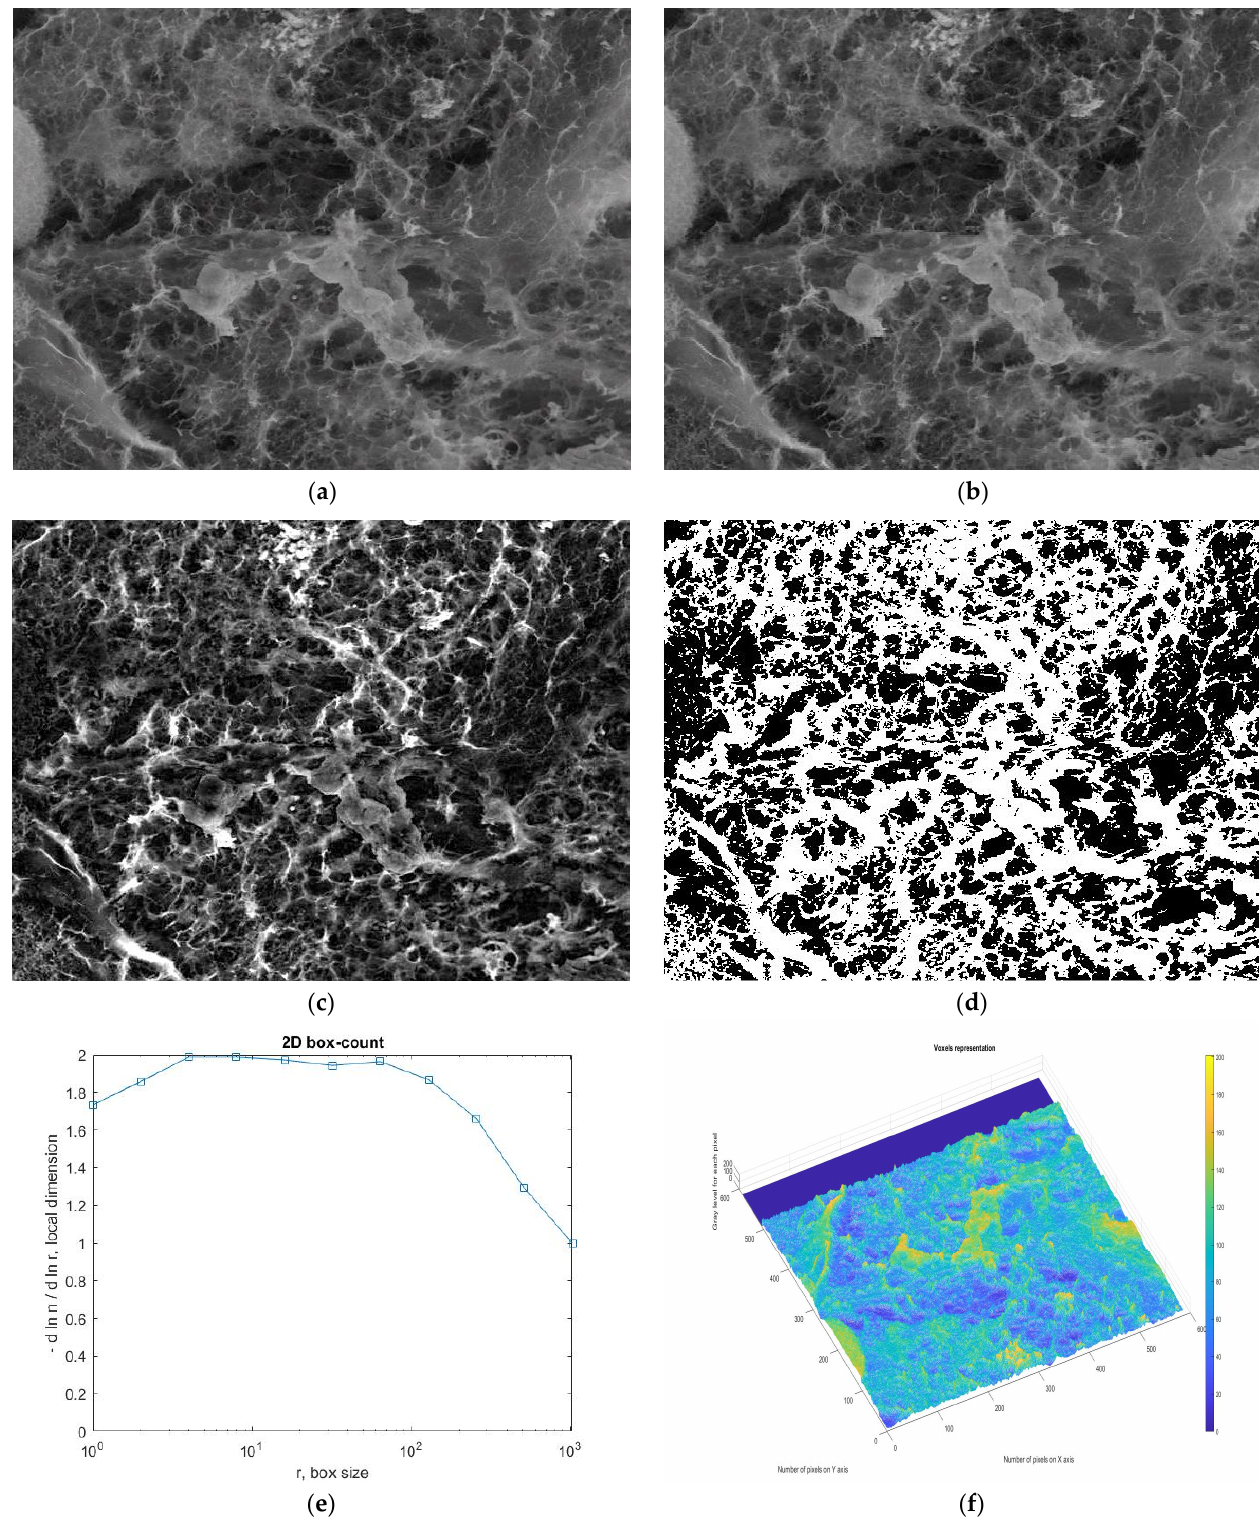
Figure 10. Fractal investigation of image C: ( a ) Black and white version of image C, ( b ) Grayscale version extracted from the background, ( c ) Grayscale version with luminance, ( d ) Binary version, ( e ) Box-count representation, ( f ) Voxel representation.